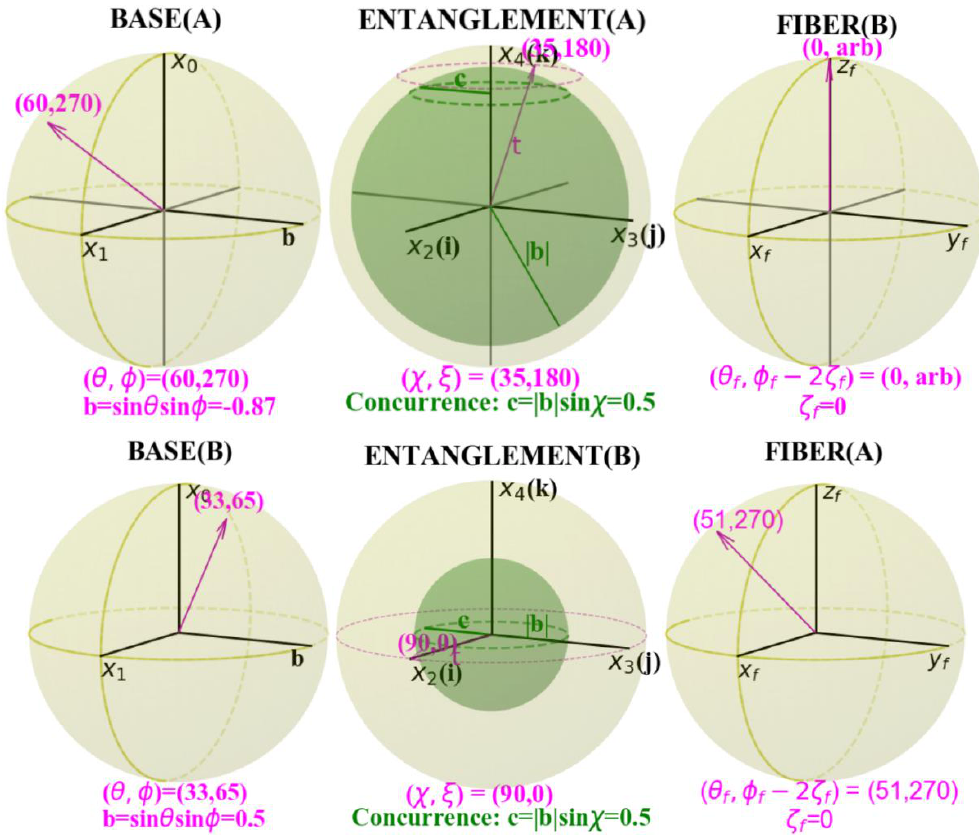
Figure 6. The two sets of Bloch spheres where qubit-A is the control qubit, after R x (60 ◦ ) ⊗ I → C-R y (70 ◦ ) in the circuit of Figure 5, where the rotation angles are η = 60 ◦ , ω = 70 ◦ , and µ = ν = 0 ◦ . Top row: qubit-A is the base qubit. Bottom row: qubit-B is the base qubit.